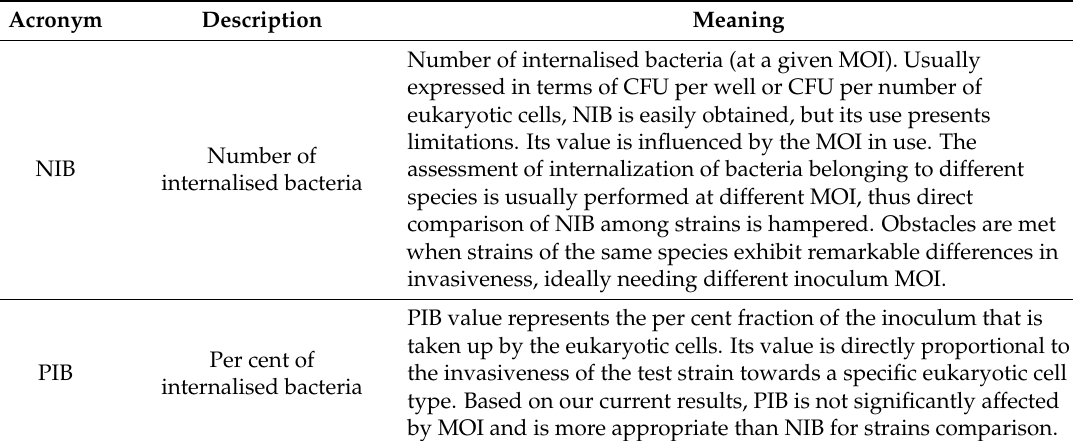
Table 1. Current parameters in use for expressing the potential of invasiveness of bacterial strains. Acronym Number of internalised bacteria (at a given MOI). Usually expressed in terms of CFU per well or CFU per number of eukaryotic cells, NIB is easily obtained, but its use presents limitations. Its value is influenced by the MOI in use. The Number of assessment of internalization of bacteria belonging to different NIB internalised bacteria species is usually performed at different MOI, thus direct comparison of NIB among strains is hampered. Obstacles are met when strains of the same species exhibit remarkable differences in invasiveness, ideally needing different inoculum MOI. PIB value represents the per cent fraction of the inoculum that is taken up by the eukaryotic cells. Its value is directly proportional to Per cent of PIB the invasiveness of the test strain towards a specific eukaryotic cell internalised bacteria type. Based on our current results, PIB is not significantly affected by MOI and is more appropriate than NIB for strains